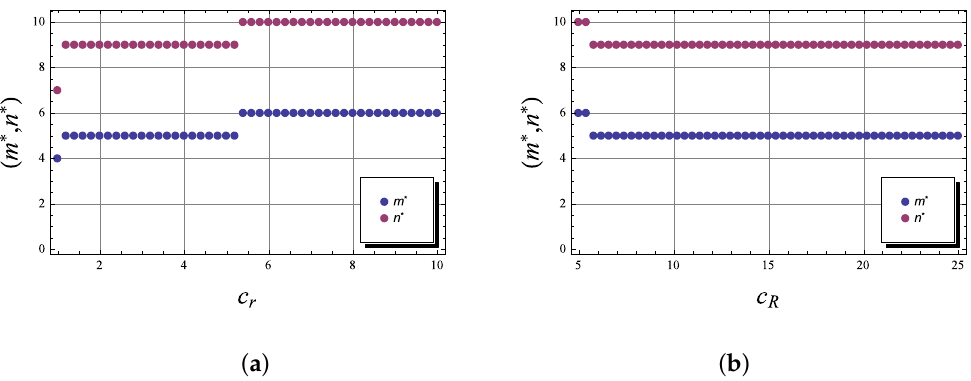
Figure 9. ( m ∗ , n ∗ ) versus c r ( a ) and c R ( b ) for the model with a preventive repair. Table 3. Comparison of different optimization problems for the model with a preventive repair. Case Nr.